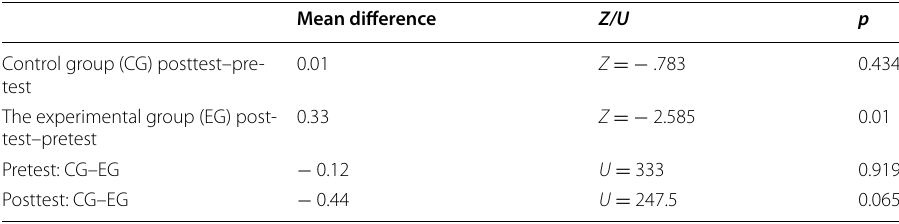
Table 9 Comparisons of the grammatical range and accuracy scores